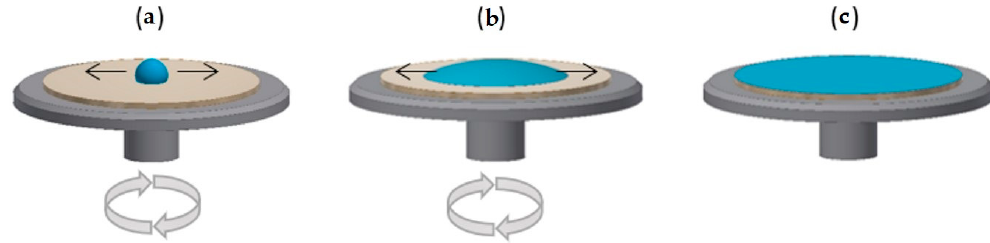
Figure 3. Schematic of the spin-coating technique: ( a ) application of the coating material on the substrate; ( b ) spreading of the coating material over the substrate via rapid rotation or spinning of the substrate; ( c ) resultant thin-film deposition across the